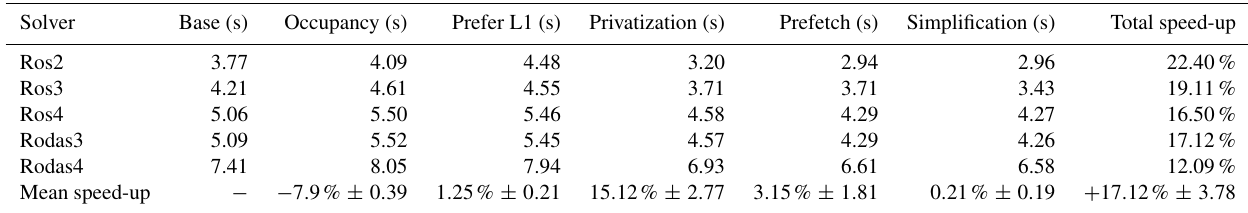
Table B2. Results running the kernel on a K80 CUDA-enabled accelerator hosted in a node equipped with an Xeon E5-2680 v3 processor at 2.5GHz.